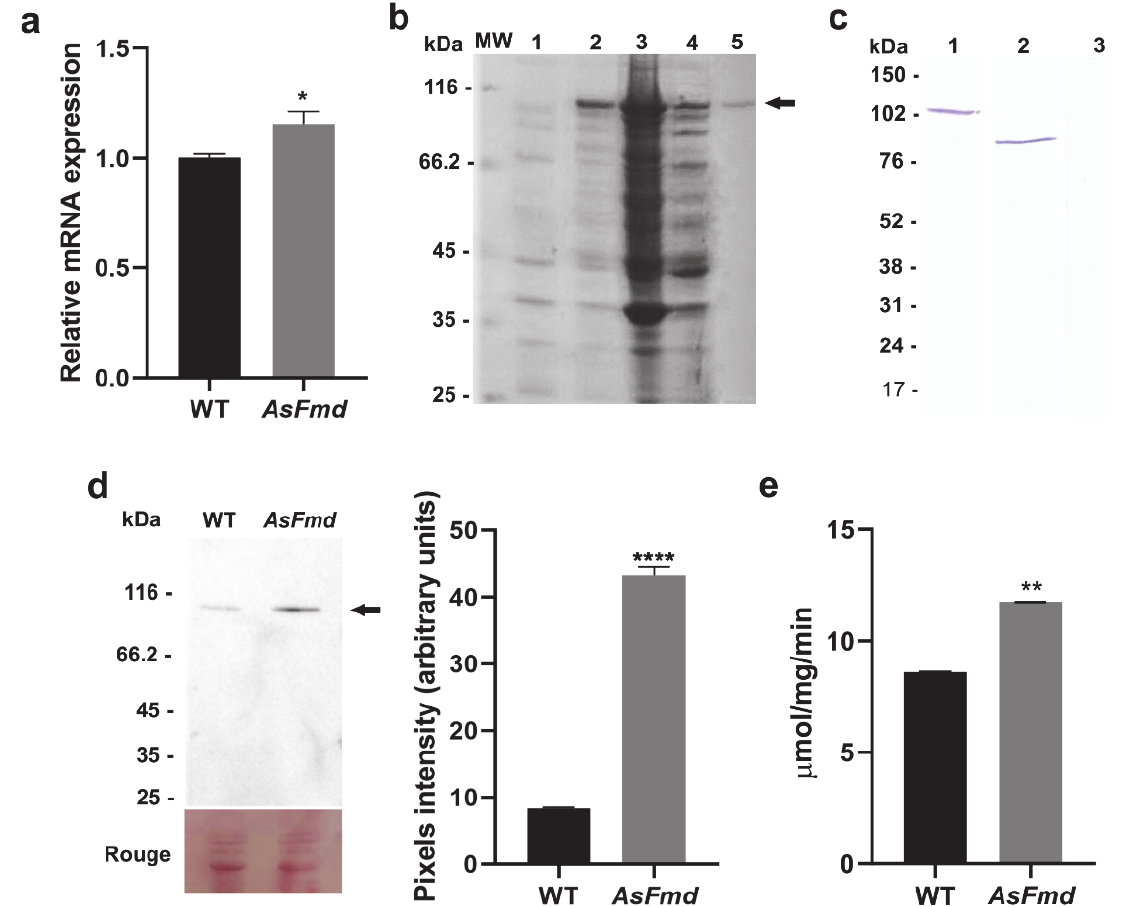
Figure 3. Urease expression, immunoblotting, and enzymatic activity analysis. ( a ): Relative quantifica- tion of urease expression in WT and AsFmd strains through RT-qPCR. The tubulin gene (PAAG_03031) was used as endogenous control. Statistical analyses were performed through Student’s t